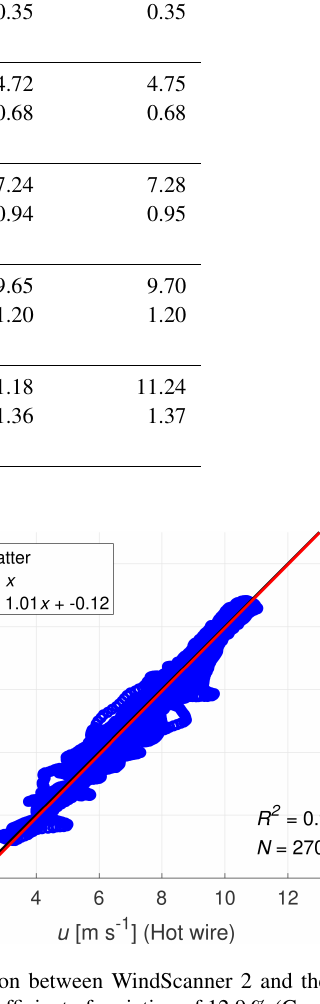
found, which is similar to the value for Case 1b in Fig. 10. The linear regression curve has a slope of 1.01 and an offset of − 0 . 12 m s − 1